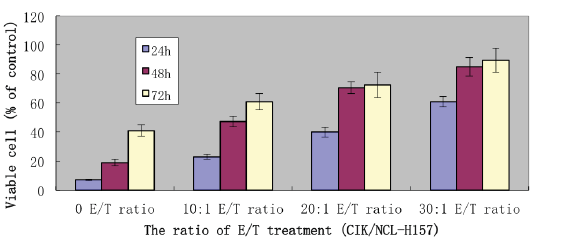
Figure 3: Effects of CIK on NCL-H157 viability (n = 5). Cell viability of NCL-H157 treated with different CIK concentrations of effector-to- target cell ratios (E/T ratio) ranged from 10:1, 20:1 and 30:1, for 24h, 48h, and 72h. (*, significant difference between the two groups, p < 0.05)